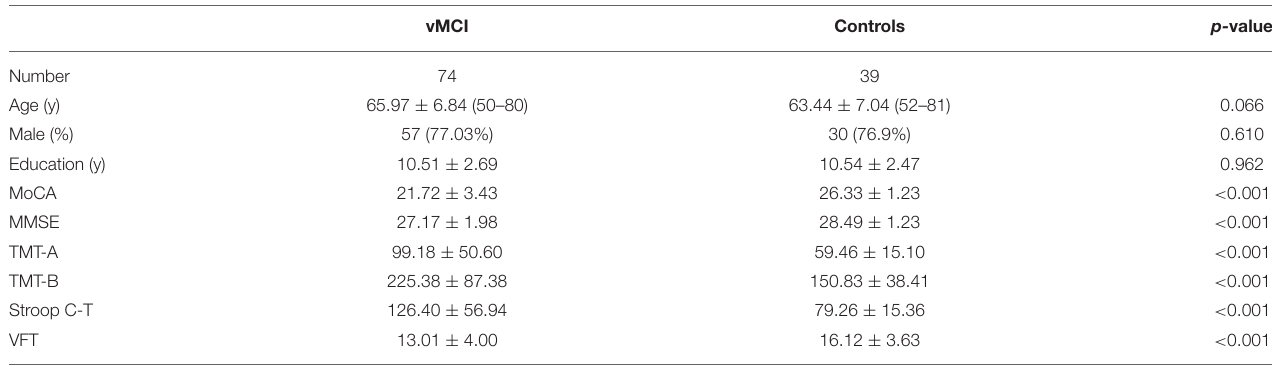
TABLE 1 | Demographic and executive function